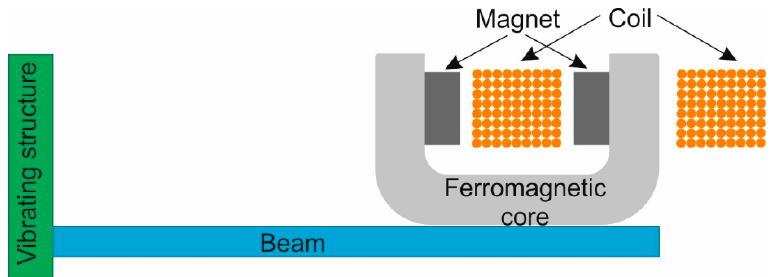
Figure 7. An electromagnetic EH generator using an elastic beam.